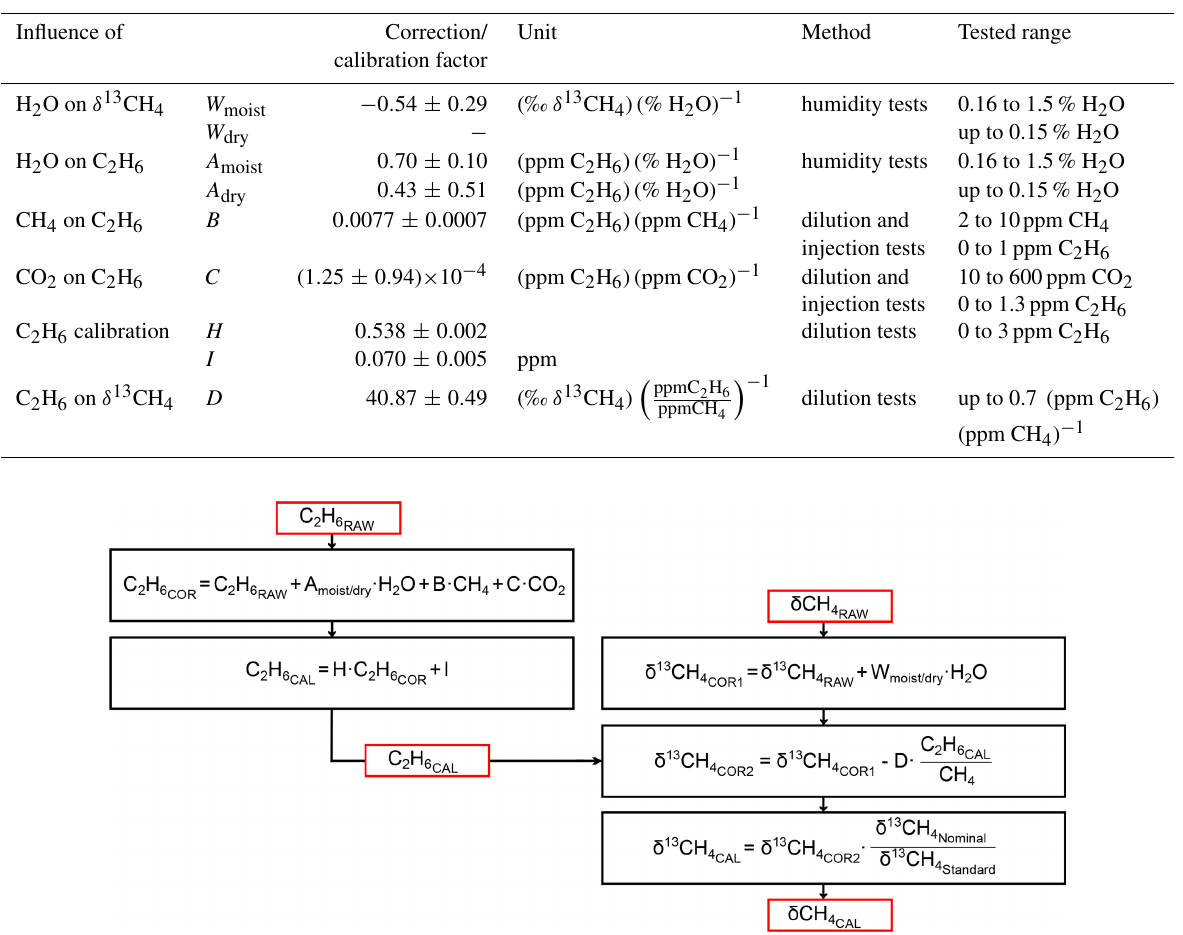
Table 1. Correction and calibration factors for C 2 H 6 and δ 13 CH 4 . The abbreviations of the correction and calibration factors in column two are re-adopted in Fig. 3.